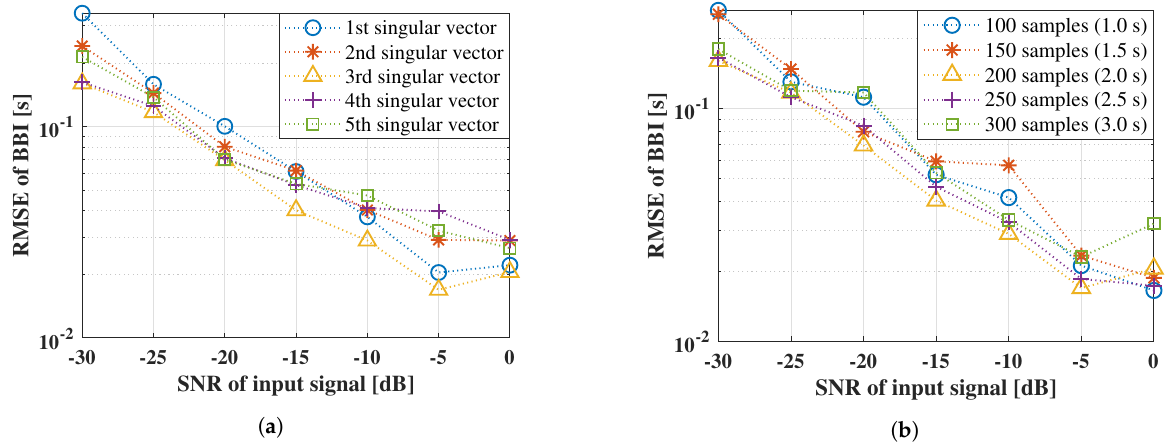
Figure 6. Accuracy evaluation of the proposed method for each parameter: ( a ) illustrates the comparison used the singular vectors, ( b ) shows comparison for the length of the lagged